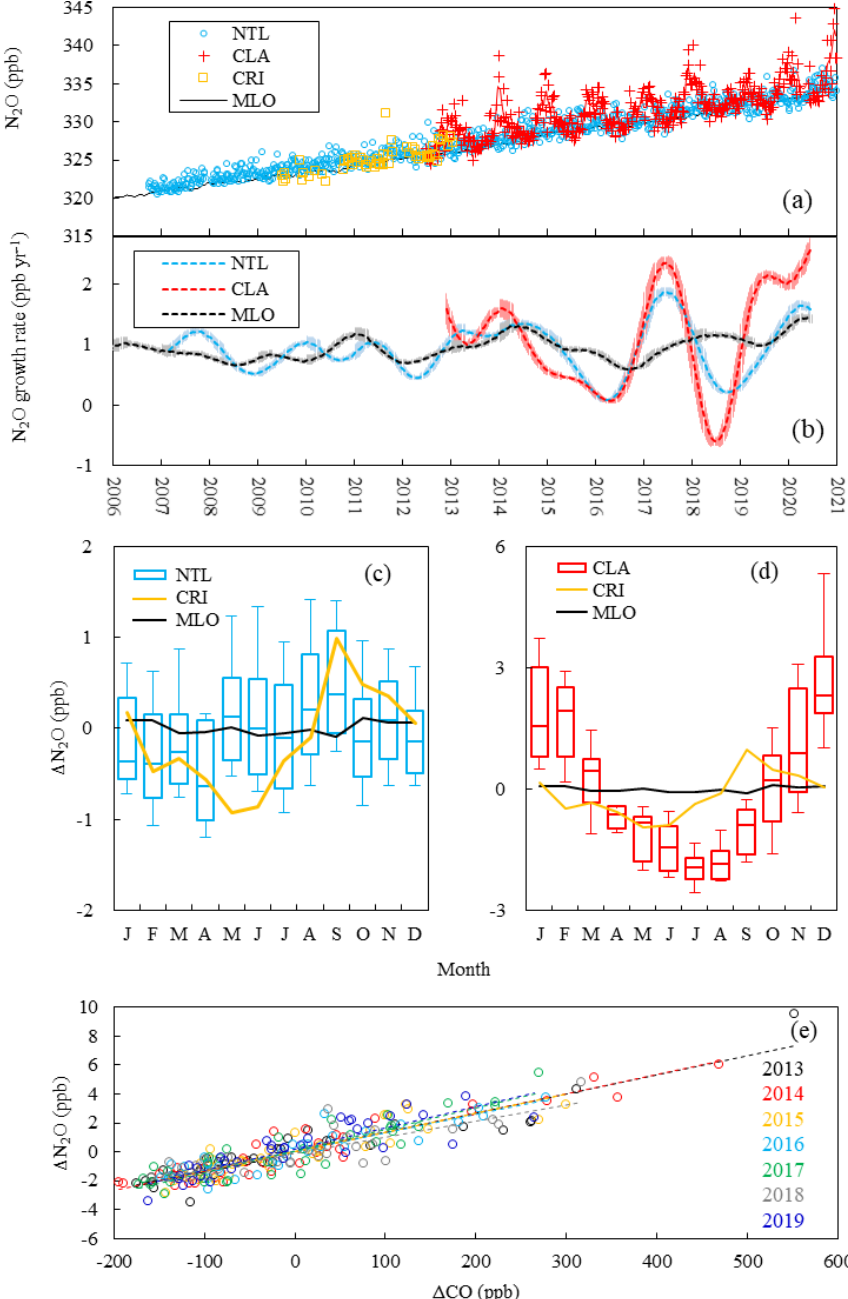
Figure 12. Time series of (a) measured values and (b) growth rates of the N 2 O mole fraction at NTL, CLA, and MLO in 2006–2020, seasonal variations in the N 2 O mole fraction at (c) NTL and (d) CLA, and (e) the relationship between the (cid:49) N 2 O and (cid:49) CO at CLA in 2013–2019.